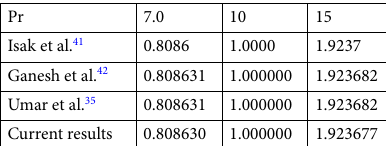
Table 1. Comparison of the results by calculating